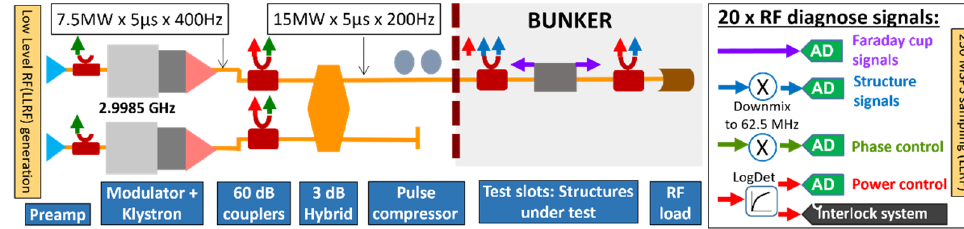
Figure 1. High-power RF system